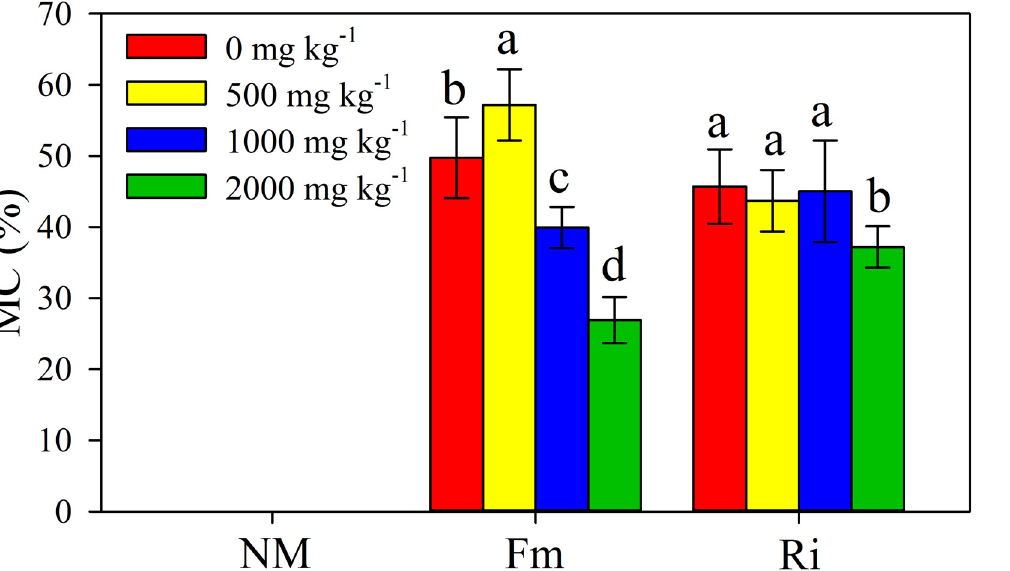
Fig 1. Mycorrhizal colonization (MC) of R . pseudoacacia was affected by Pb stress levels. NM, non-inoculated control; Fm, inoculated with F . mosseae ; and Ri, inoculated with R . intraradices . The results are reported as the mean (n = 6) ± SD. The same letter indicates no significant difference among treatments (Duncan ’ s test, P < 0.05). Two-way ANOVAs were used to determine the significance of the effects of the Pb level (Pb), AMF inoculation (AMF), and their interactions (Pb × AMF) on the MC of black locust seedlings, as shown in S1